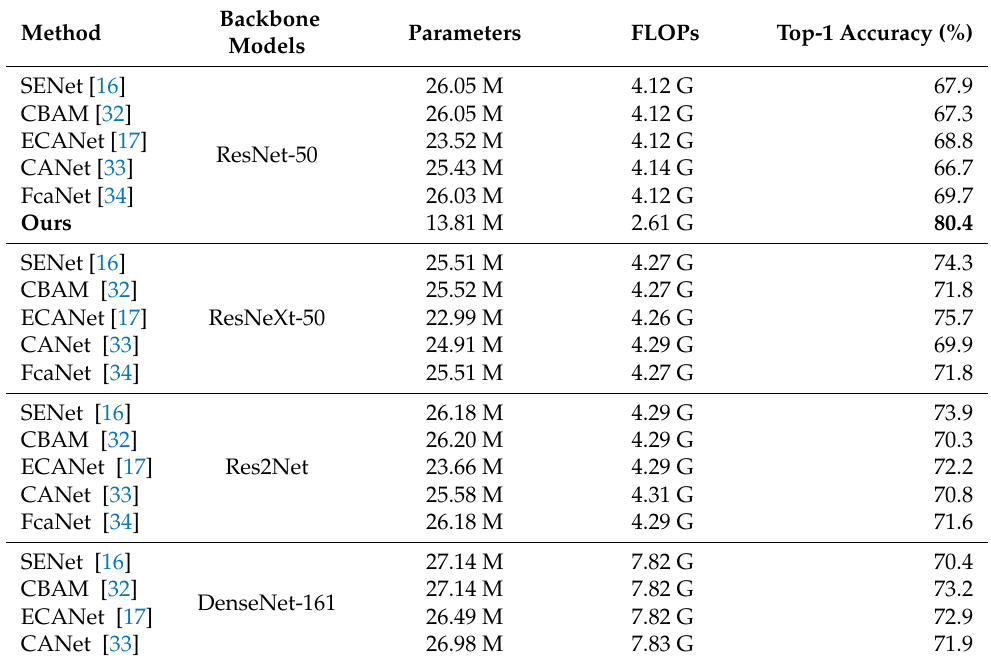
Table 6. Comparative experimental results of MFANet and various neural networks with added attention methods on the Collar6 dataset.